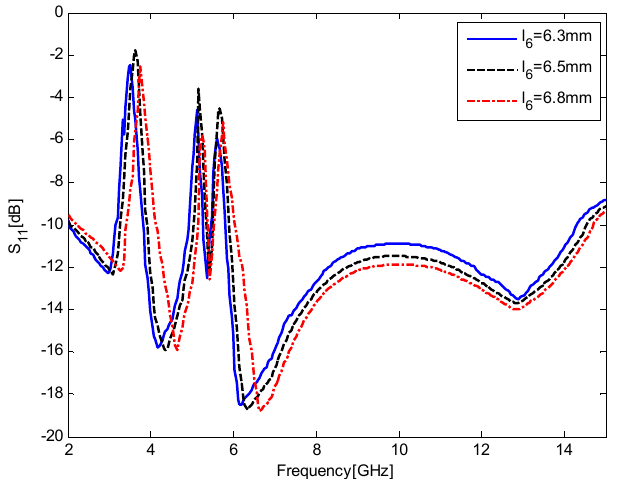
Figure 8. Simulated S 11 results for the antenna as a function of l 6 , the vertical length of the inverted T- inverted slots.